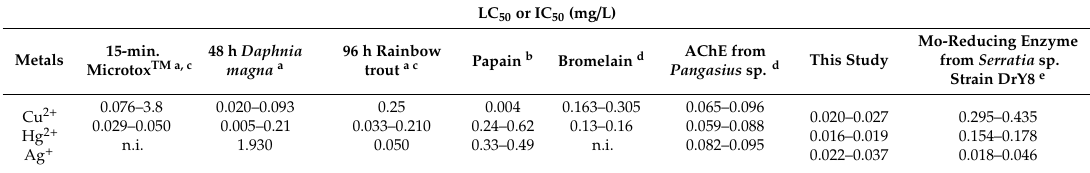
Table 5. Comparison of the developed ficin dye-binding assay to various other assays. The range is 95% Confidence Interval.